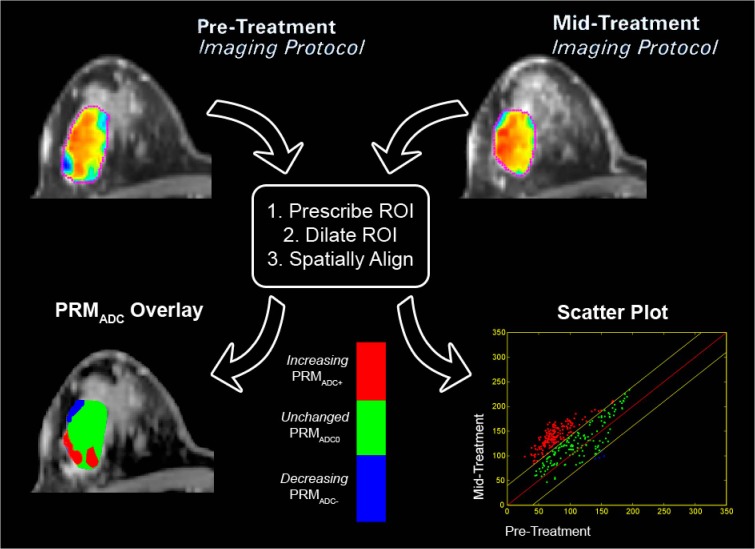
Pictorial representation of the PRM analytical process on ADC maps.Regions of interest (ROI) are prescribed on the pretreatment anatomical images. ROI are then dilated to encompass neighboring tissue around tumor. Control points are automatically distributed throughout the new ROI, where three-five control points must be user defined. Diffusion–weighted MRI data undergoes co-registration to pretreatment anatomical image. Registered pre and mid-treatment ADC maps are used to generate a three-color overlay representing regions in which tumor ADC values significantly increased (red voxels), significantly decreased (blue voxels) or remain unchanged (green voxels). This data can also be presented in a scatter plot and percentages assigned to the three defined ADC regions, allowing quantitative assessment of overall changes in tumor ADC values.